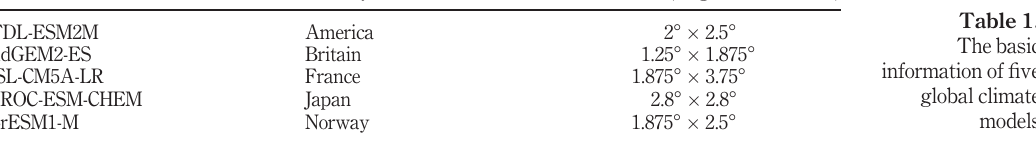
Figure 1. The location of